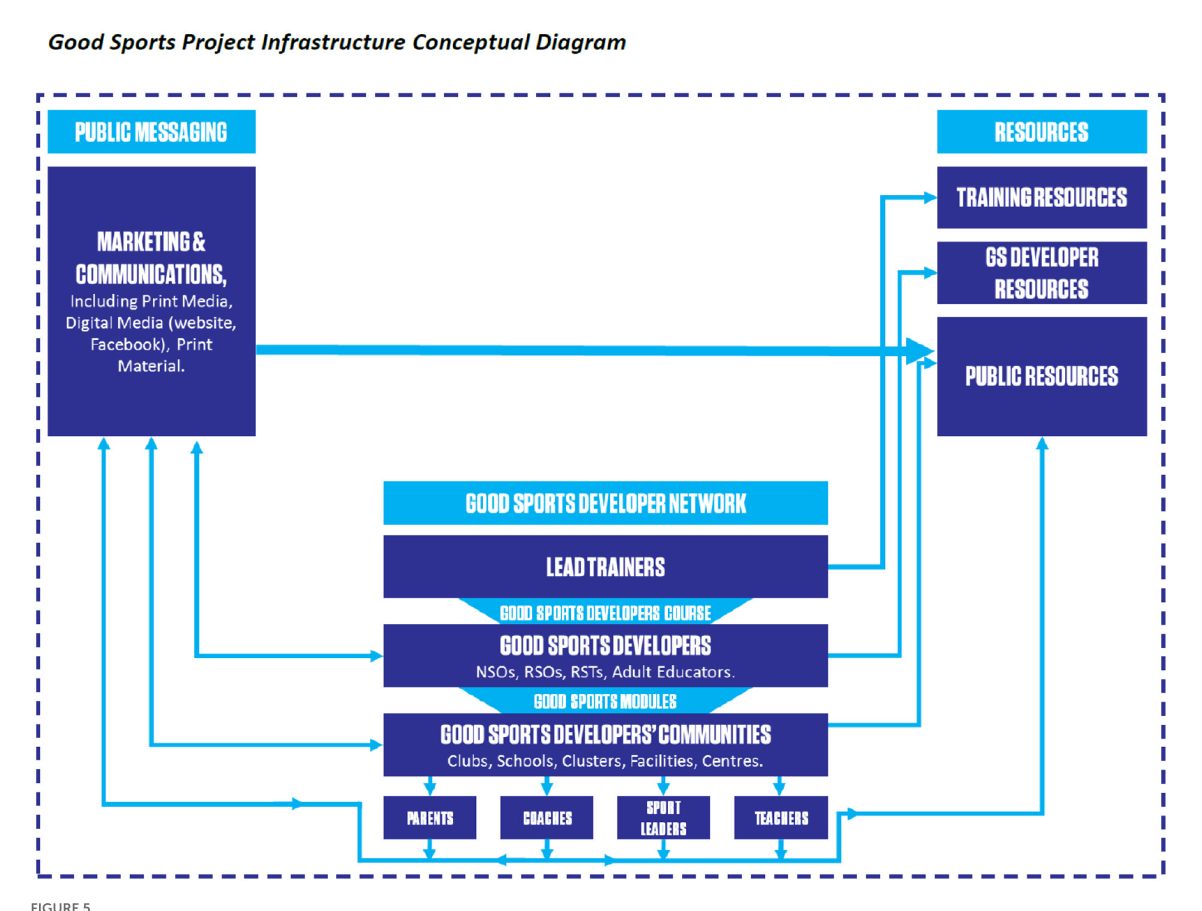
FIGURE5 Good Sports programme